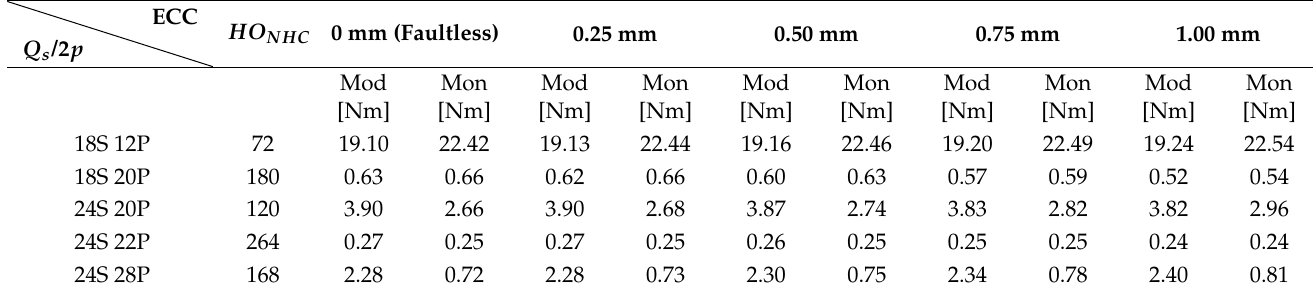
Table 12. Cogging torque NHC of different PMSM and MPMSM slot/pole combinations in the presence of